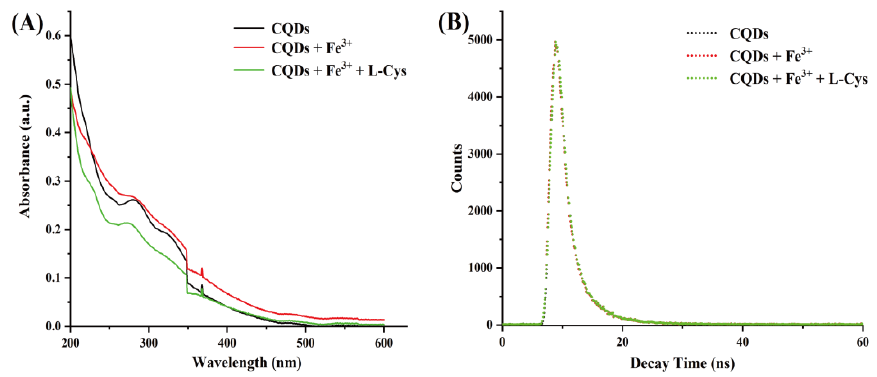
Figure 4. ( A ) UV-vis spectra and ( B ) fluorescence spectra of CQDs, CQDs/Fe 3+ , and CQDs/Fe 3+ /L- Cys.